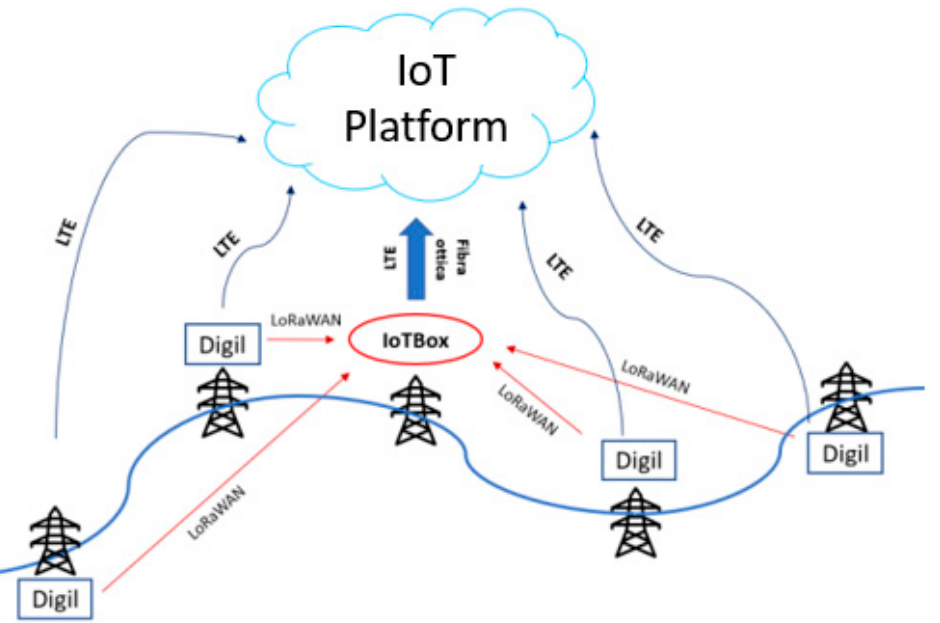
Figure 1. Data acquisition scheme.